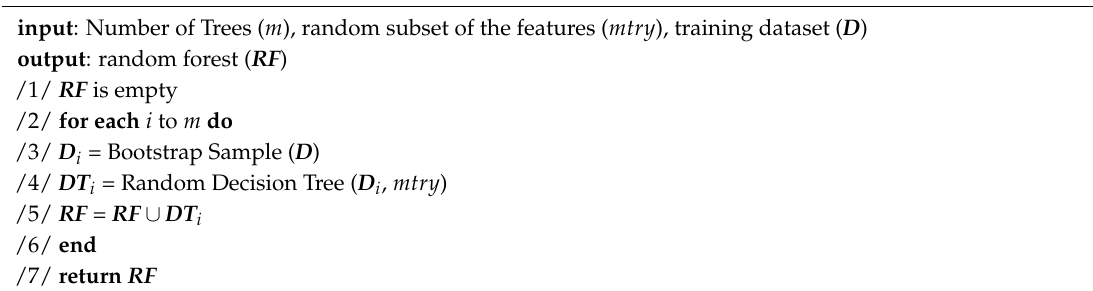
Algorithm 2 : Random Forest algorithm